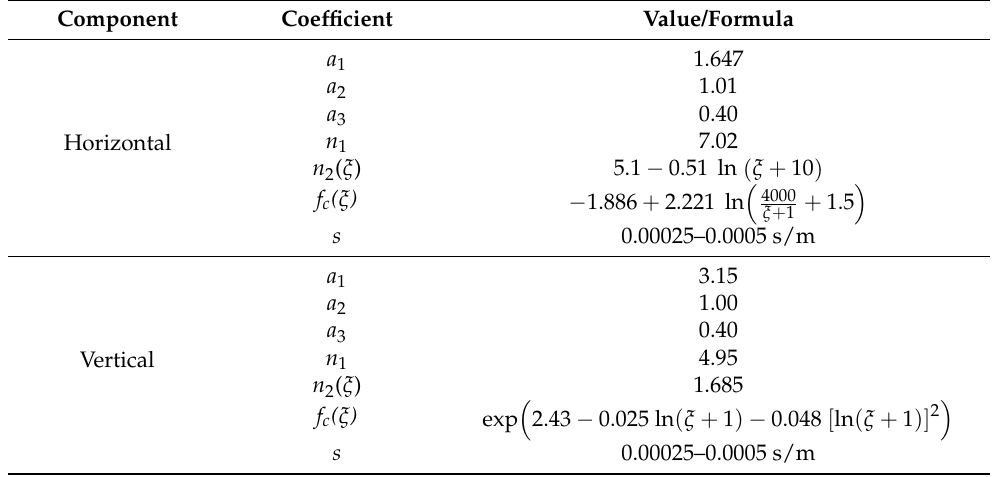
Table 1. Values of coherency function coefficients [59]. Component Coefficient Value/Formula